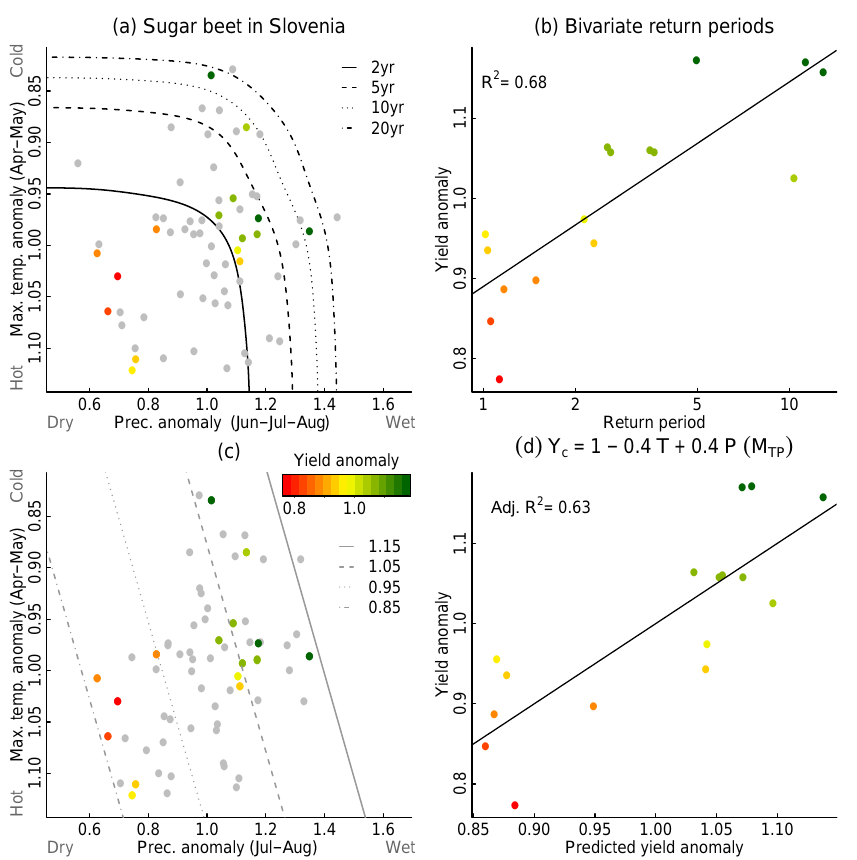
Figure 3. Sugar beet in Slovakia, similar to Fig. 1. (a) Maximum temperature anomalies averaged over April and May vs. precipitation anomalies averaged over summer (June, July, and August). Dots are coloured according to sugar beet yield anomalies if yield data were available and are grey otherwise. Dry and hot conditions are on the lower left. (b) Yield anomalies of sugar beet vs. bivariate return periods. The line indicates the best linear fit with R 2 = 0 . 68. (c) As in (a) but with precipitation averaged over July and August. Lines indicate levels of equal yield anomalies as predicted by the linear model M TP . (d) Linear model using predictors from (c) ( M TP ). The adjusted R 2 is 0.63. The line denotes the 1:1